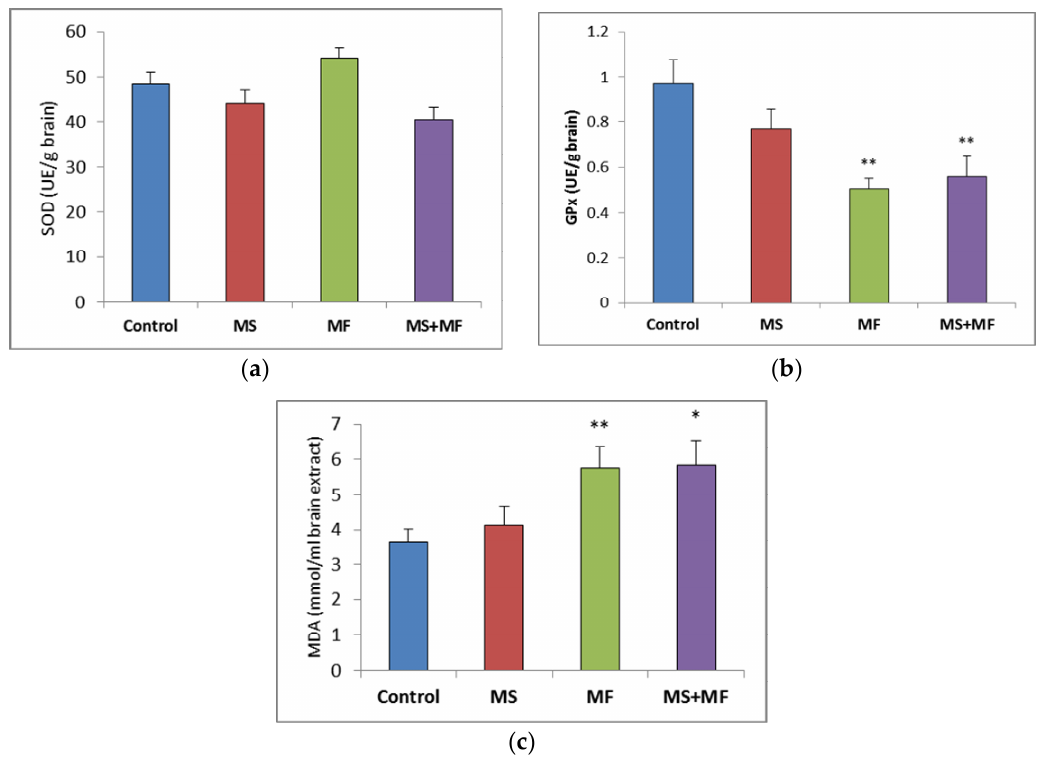
Figure 6. The effect of various combinations of stress factors on oxidative stress markers in the mice brain: ( a ) SOD activity, ( b ) GPx activity and ( c ) MDA levels. The values are mean ± S.E.M. ( n = 10 per group, * p < 0.05, and ** p < 0.01, MS = maternal separation, MF = multifactorial stress).